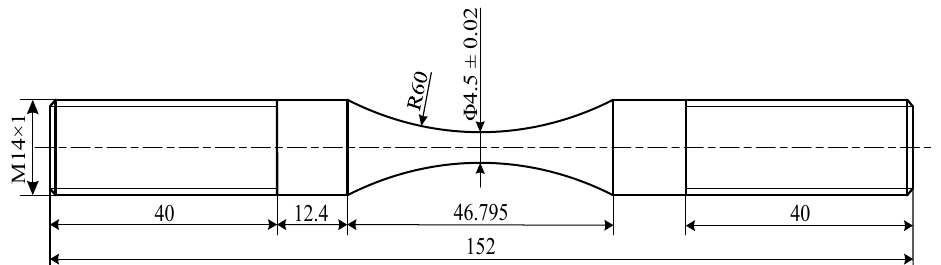
Figure 1. The dimensions and shape of fatigue specimen (unit: mm).